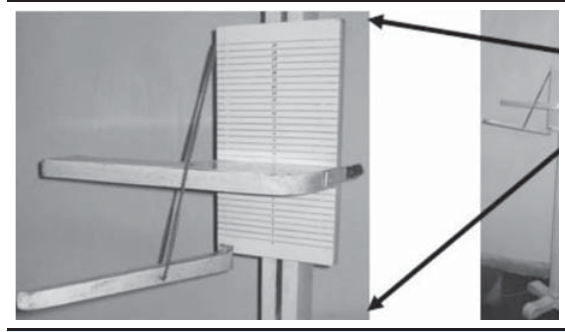
Figure 2. Indigenously developed venous pressure